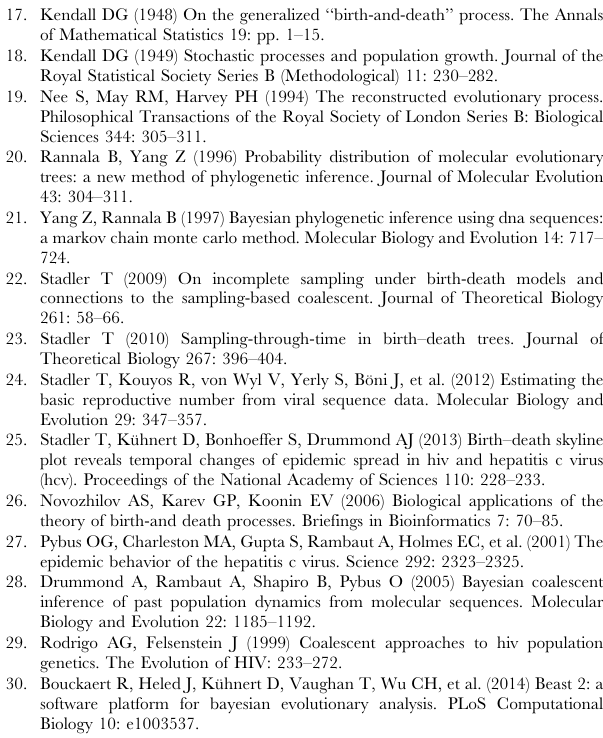
and the HPD summary for the birth-death trees (A, C, E,…) and the coalescent trees (B, D, F,…). See the legend of Figure 7 for detailed description. (TIF) Table S1 Summary of growth rate parameter estima- tion statistics at various r ~ l { d corresponding to the same R 0 . For each of the 100 trees simulated under the respective model (the birth-death or the coalescent), with p ~ 0 : 5 and various growth rates r ~ l { d corresponding to R 0 ~ f 11,2,1 : 14,1 : 1 g , we estimated the coverage, the 95% HPD interval sizes and RMSE of r by the birth-death model and the coalescent model, and display the summary of these measures. Each value of R 0 that corresponds to the same growth rate r ~ 0 : 5 across all the R 0 settings is marked in bold. Different simulations corresponding to the same R 0 are separated by horizontal double line. (PDF) Table S2 Summary of growth rate parameter estima- tion statistics in various sampling scenarios. For each of the 100 trees simulated under the respective model (the birth- death or the coalescent), with periods of p ~ 1 sampling probability alternating with periods of p ~ 0 or p ~ 0 : 2 , we estimated the coverage, the 95% HPD interval sizes and RMSE of r by the birth-death model (1 interval), the birth-death skyline model allowing for varying sampling proportion p (10 equidistant intervals for p ) and the coalescent model, and display the summary of these measures. Different simulations corresponding to the same R 0 are separated by horizontal double line. R 0 ~ 128 corresponds